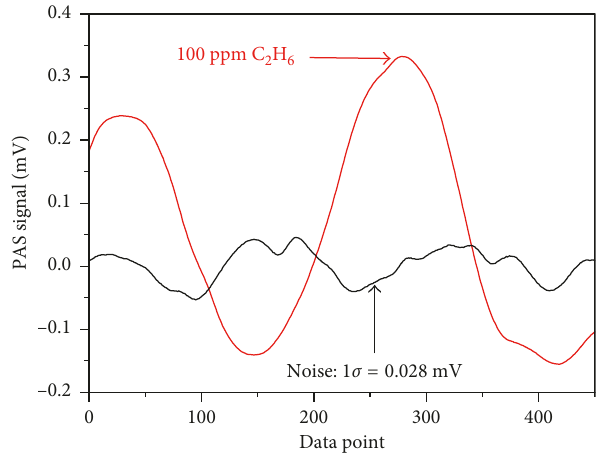
Figure 7: PAS signal of 100ppmv C